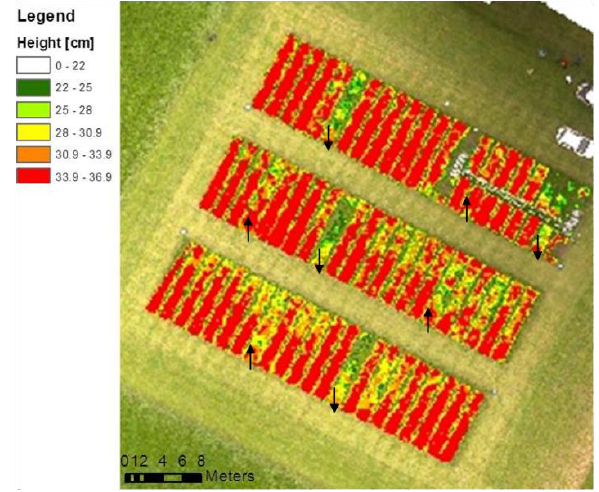
Figure 9. Height variation within plots by applying the NDRE index on the acquired hyperspectral dataset of May. The plots with the lowest inorganic fertilization level (0 kgN/ha) are indicated with an arrow down and plots with the highest inorganic fertilization level (340 kgN/ha) are indicated with an arrow up.